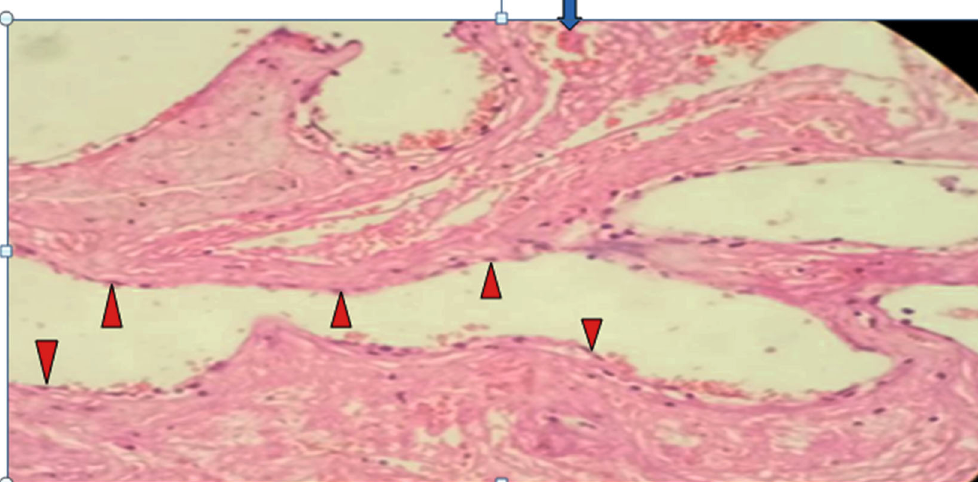
Figure 7: High-power photomicrograph revealing foci of inner cyst wall lined by a single layer of bland fl attened epithelial cells, likely mesothelial cells (red arrowheads) and foci of hemorrhage (blue arrow).